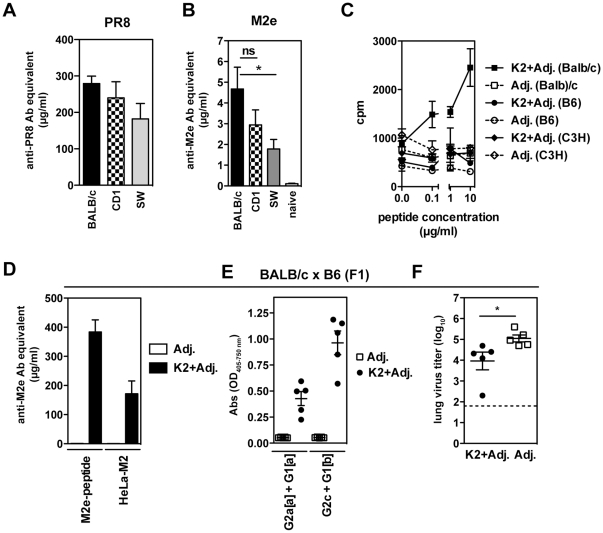
Genetic impact on anti-M2e immunity.(A and B) BALB/c, CD1/ICR and Swiss Webster (SW) mice (n = 5–6 mice) received three consecutive infections, first with influenza virus A viruses PR8, secondly with PR8-SEQ14 and thirdly with X31. PR8-specific IgG (A) and M2e-specific IgG (B) in sera were determined after first and third infection, respectively. The results of sera from naive mice (n = 1/mouse strain) were pooled. (C) BALB/c, C57BL/6, and C3H mice were immunized s.c. with K2 peptide and adjuvants or adjuvants alone. The draining lymph node was harvested on day 8 and proliferation was assessed by incorporation of [3]H-thymidine during the fourth day of an in vitro culture in presence of K2 peptide. One out of two independent experiments shown. (D–F) BALB/cxC57BL/6 (F1) mice (n = 5 mice) were immunized i.n. with K2 and adjuvants or adjuvants alone. (D) M2e-specific Ab titers measured in an ELISA against M2e-peptide or HeLa-M2 cells in serum of BALB/cxC57BL/6 (F1) mice after third immunization. (E) M2e-specific serum Abs at a 1∶150 serum dilution were determined with allotype-specific reagents (IgG2a[a] and IgG1[a] for BALB/c and IgG2c and IgG1[b] for C57BL/6 origin). (F) After the third immunization, BALB/cxC57BL/6 (F1) mice were challenged with X31 (1000 TCID50/5 µL) and infectious virus in the lungs was determined 5 days post challenge.